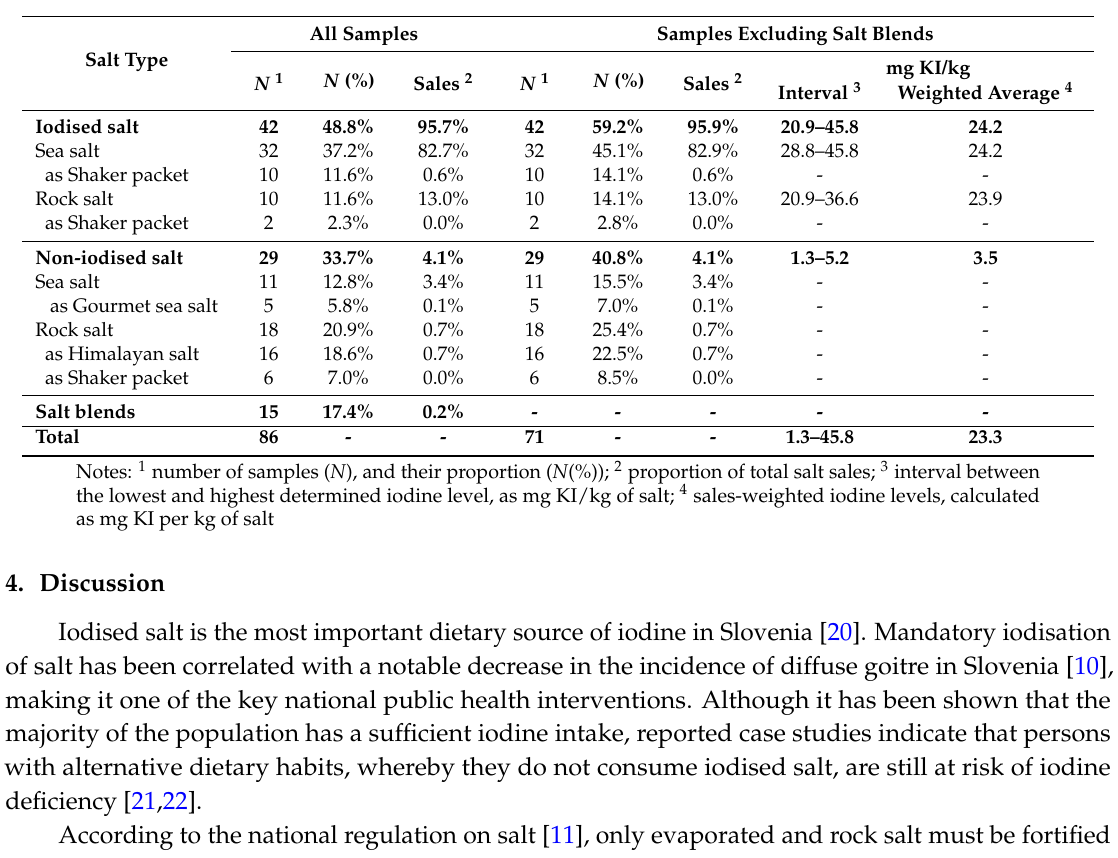
Table 1. Availability of (non-)iodised salt, proportion of total salt sales and iodine content by type of salt (Slovenia,